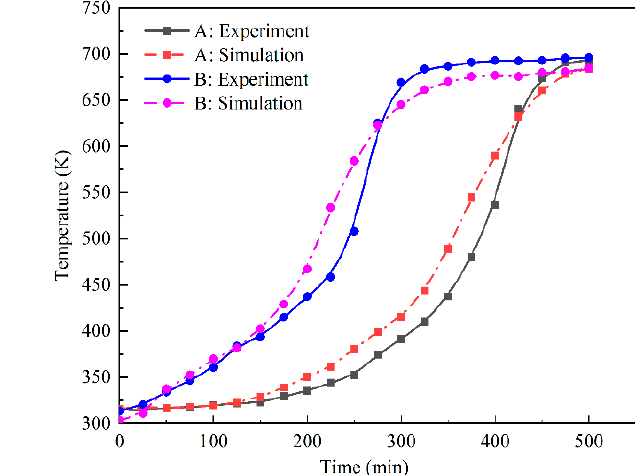
Figure 5. Comparison between the experimental and simulated results.